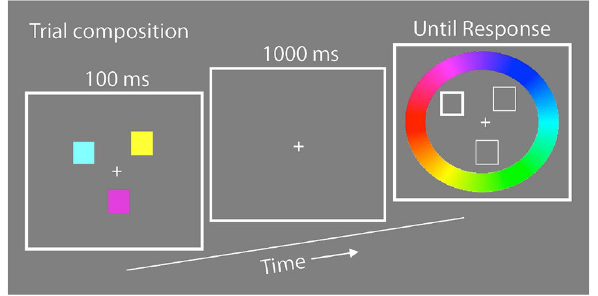
colour is calculated and tabulated across